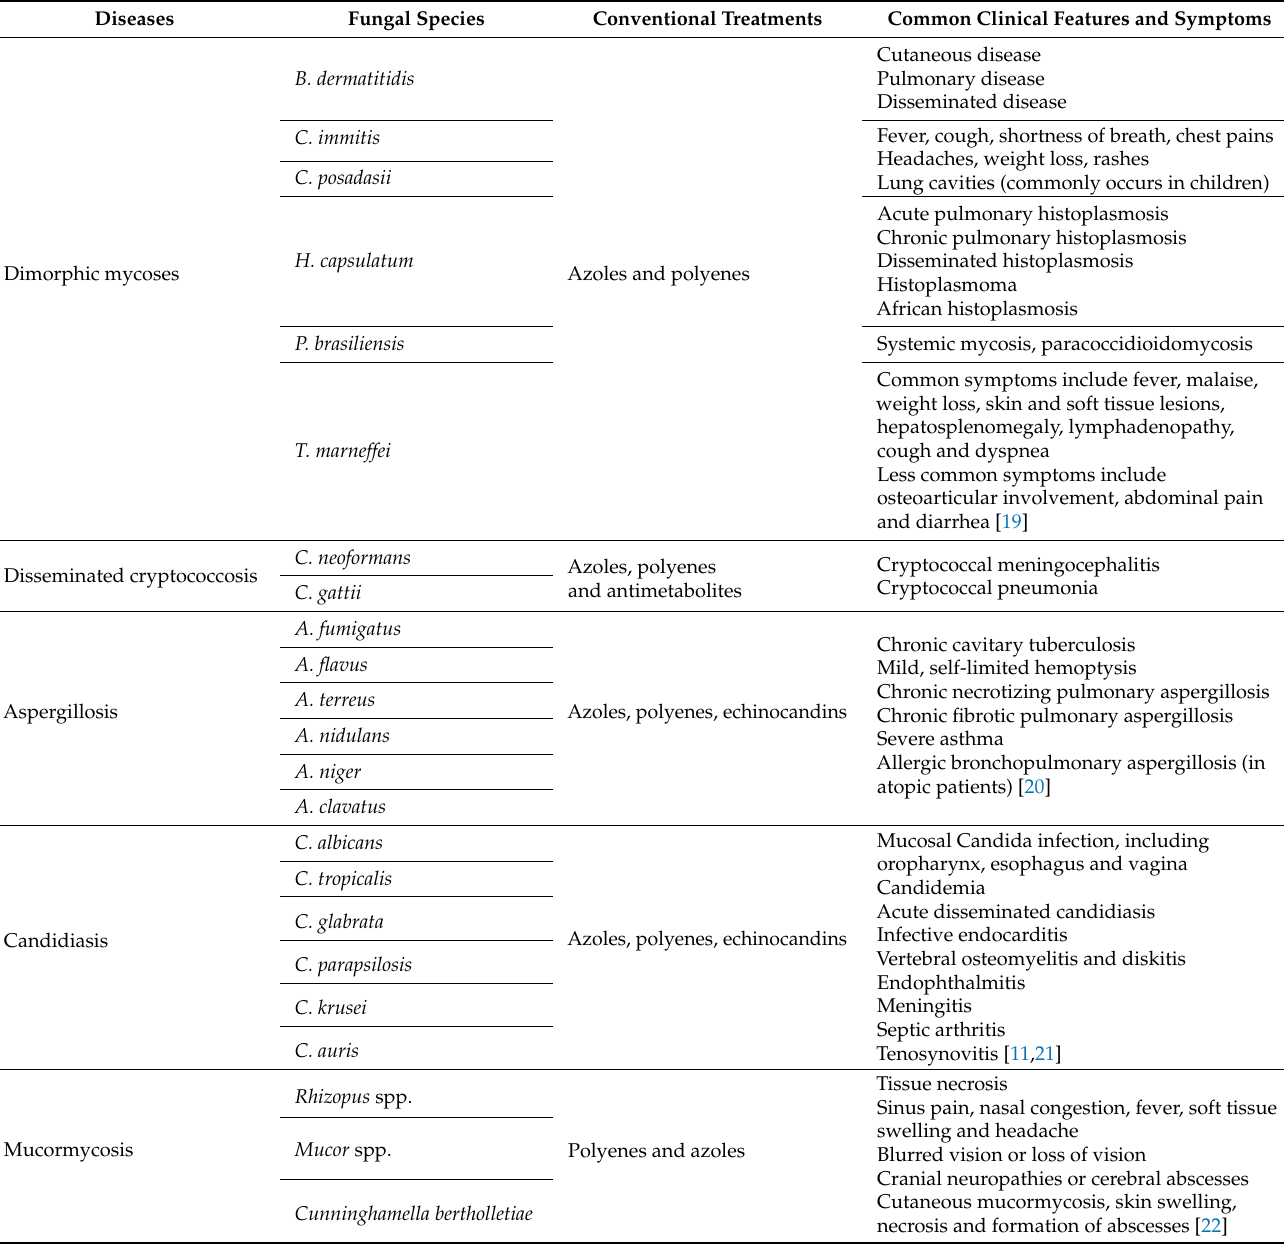
Table 1. Pathogenic fungi caused human